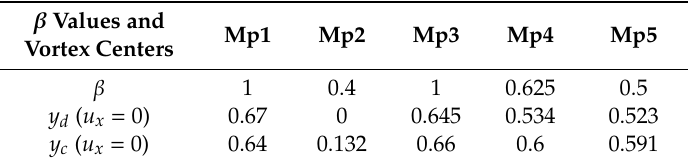
Table 2. Vortex centers in the micropit with di ff erent β